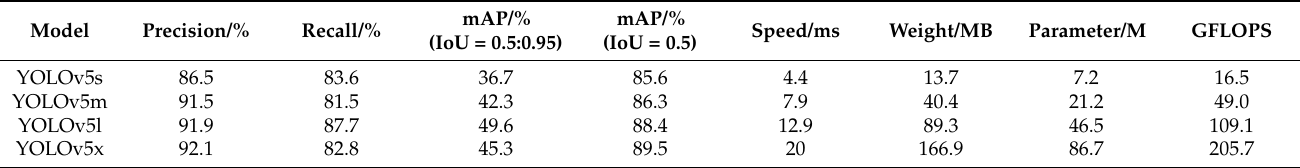
Table 3. Detection results of different YOLOv5 models on the cows’ mounting